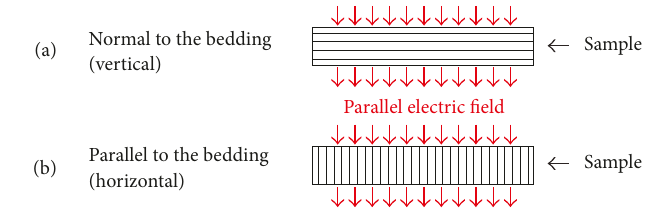
Figure 5: Parallel plate measurement schematics. Black lining illustrates the bedding of the sample.